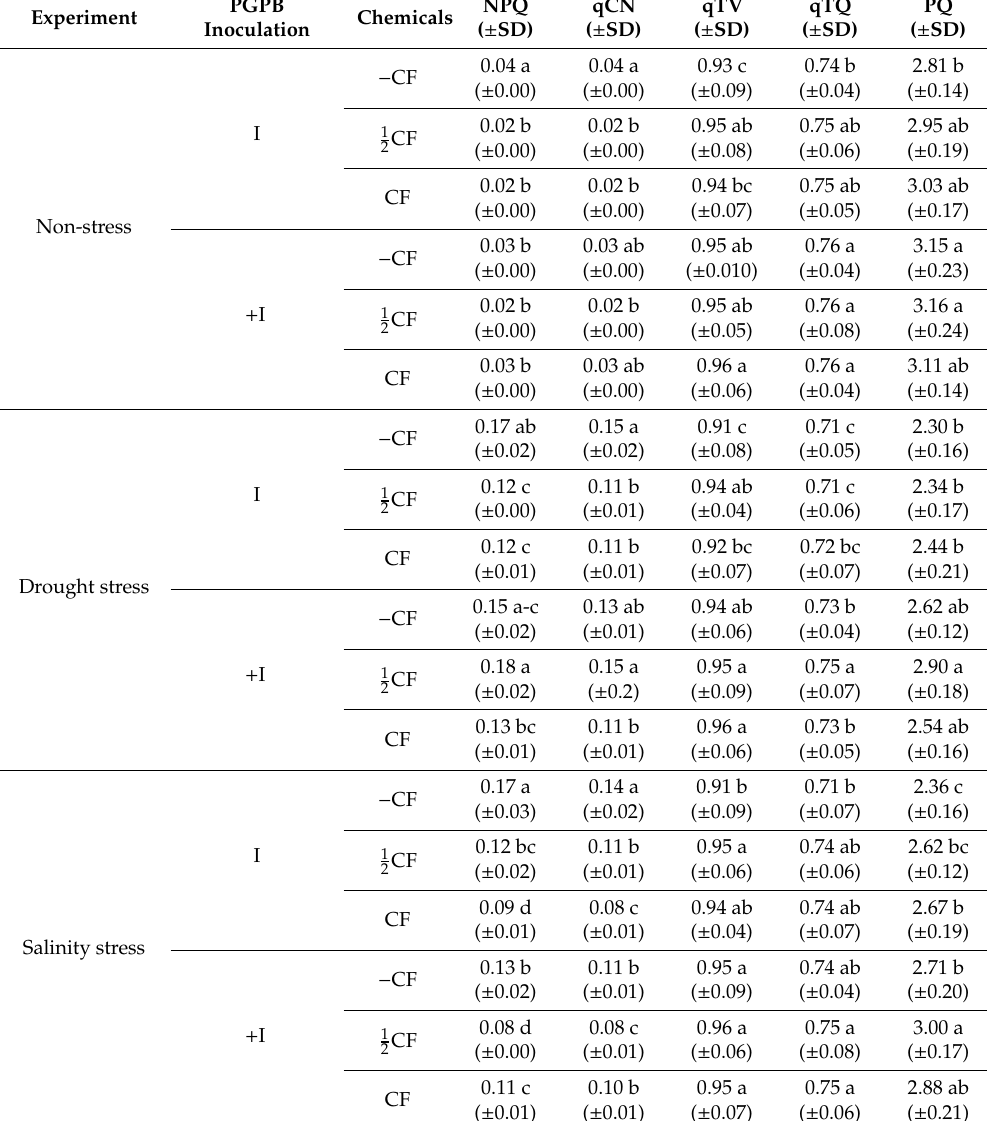
Table 3. Photo-protective energy dissipation of photosystem II in response to the chemical / microbiological fertilization management under non-stress, drought, and salinity